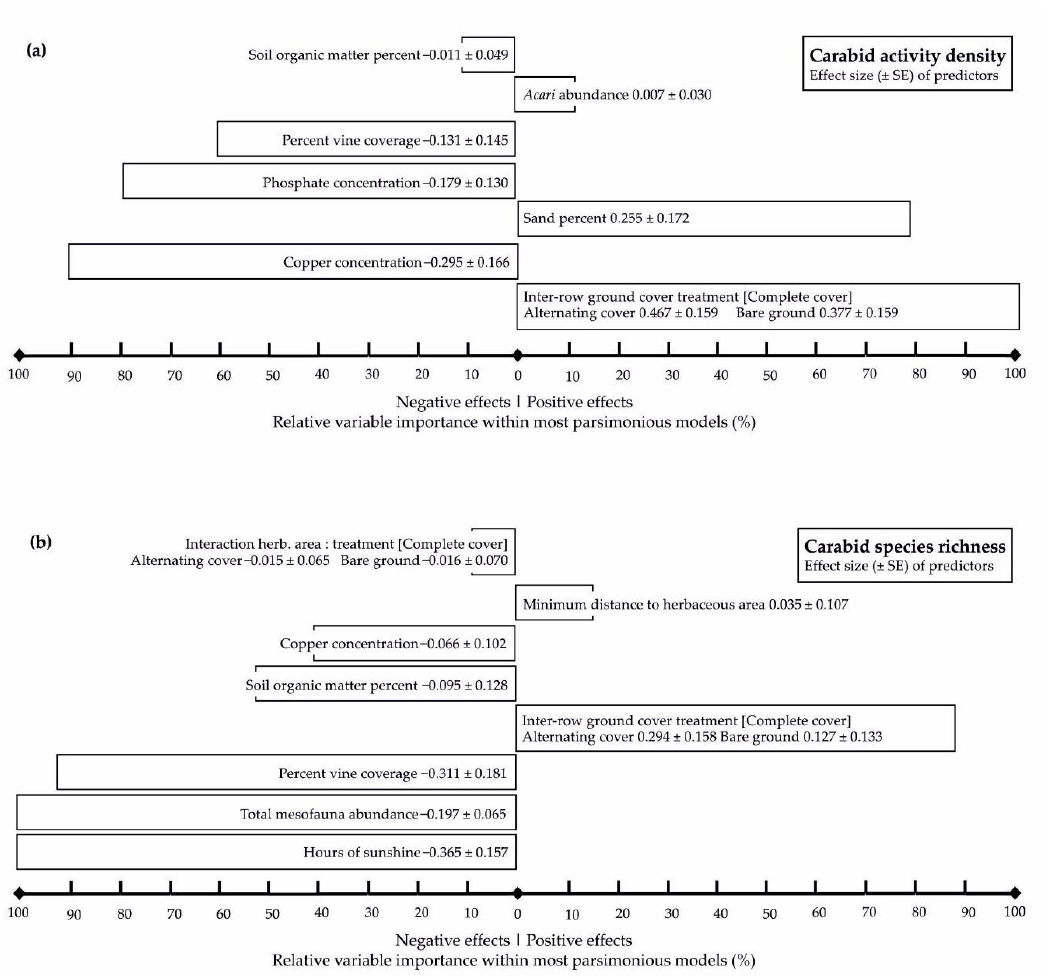
Figure 4. The relative variable importance within the most parsimonious models for ( a ) carabid activity density and ( b ) species richness. Percent relative importance for each explanatory variable was calculated accordingly [69], with negative effects indicated to the left and positive effects indicated to the right. Effect sizes (estimate values ± SE) are derived from model averaging